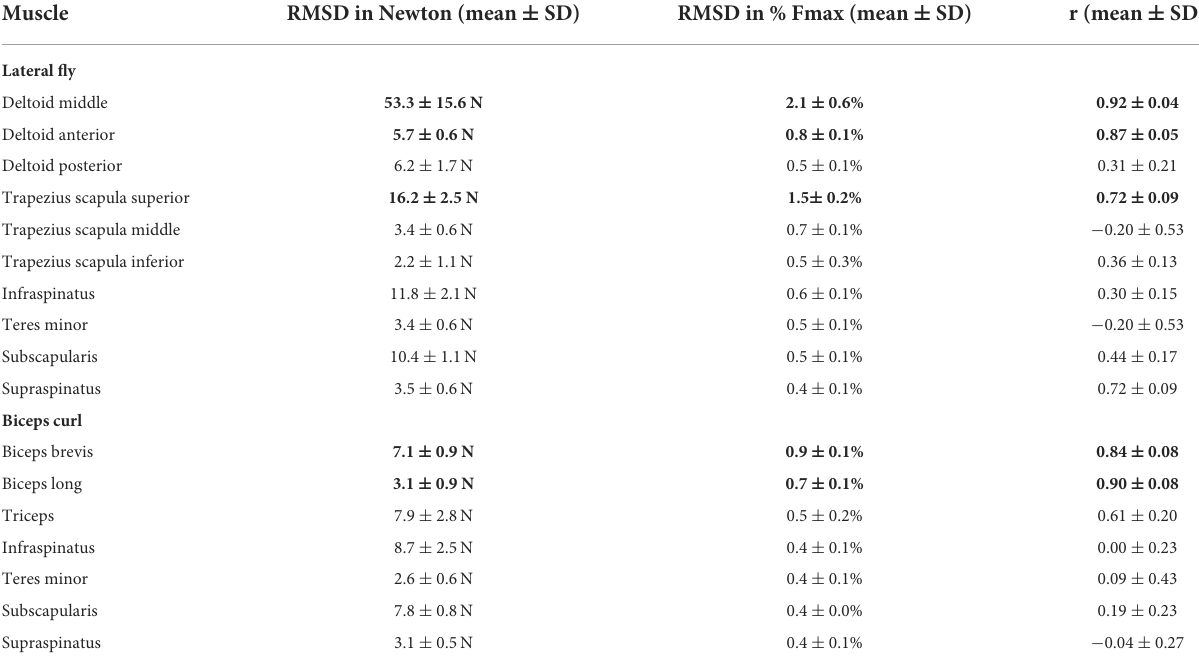
TABLE 3 Mean Root-Mean-Square-Deviations (RMSD) expressed in Newton (N) and in percentage of the maximum muscle force (Fmax) and Pearson’s correlation (r) between the OMS and the camera methods. Muscle RMSD in Newton (mean ± SD) RMSD in % Fmax (mean ± SD) r (mean ± SD)